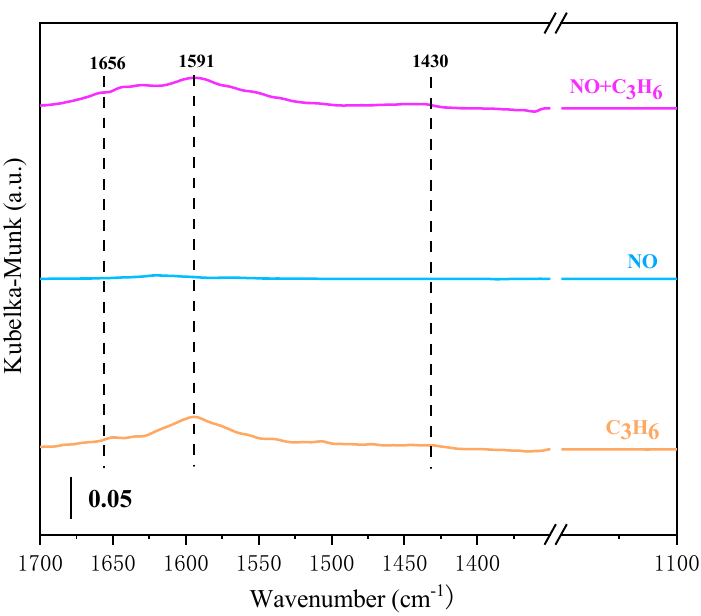
Figure 10. DRIFTS spectra of chemisorbed of NO, C 3 H 6 , and NO + C 3 H 6 over the Cu-SAPO-34 catalysts at 200 °C.